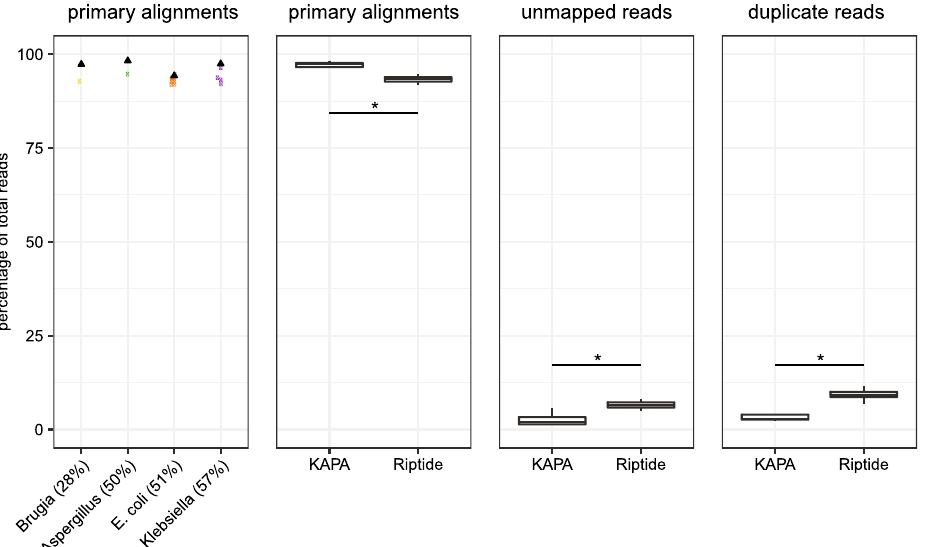
Figure 3. Comparison of mapping performance in Riptide versus KAPA Hyper libraries. ( A ) The percentage of primary alignments in Riptide and KAPA Hyper libraries were determined after mapping randomly subsampled read sets to individual genomes and subsequent removal of unmapped reads, duplicate reads, secondary alignments (repeats), and supplementary alignments (chimeras). secondary alignments. SAMtools was used to filter read sets. Colored circles denote Riptide libraries, black triangles denote KAPA Hyper libraries. After grouping all Riptide libraries (n = 16) and all KAPA libraries (n = 4), a Welch’s t test was performed to compare the percentages of ( B ) primary alignments, ( C ) unmapped reads, and ( D ) duplicated reads. *Differences between Riptide and KAPA Hyper distributions were significant (p value <